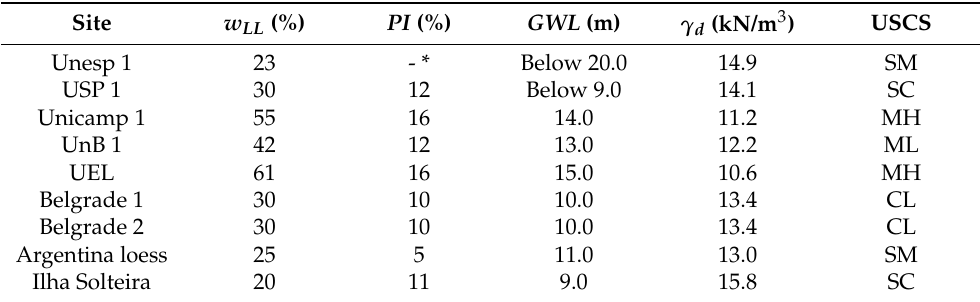
Table 2. Typical values of the liquid limits ( w LL ), plasticity index ( PI ), ground water level ( GWL ), in-situ dry unit weight ( γ d ) and USCS classification for the soils from each